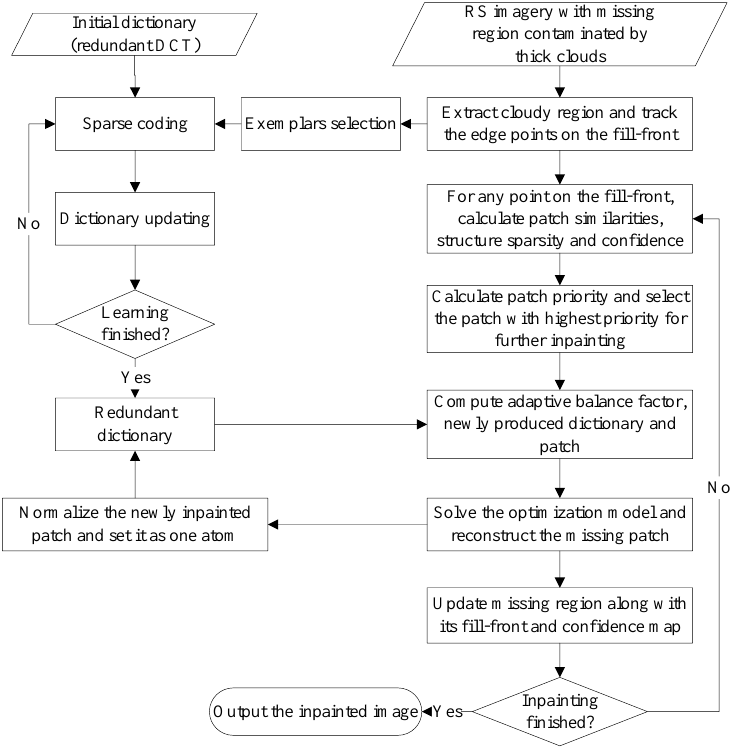
Figure 3. The Flowchart of Our Thick Clouds Removal Scheme.